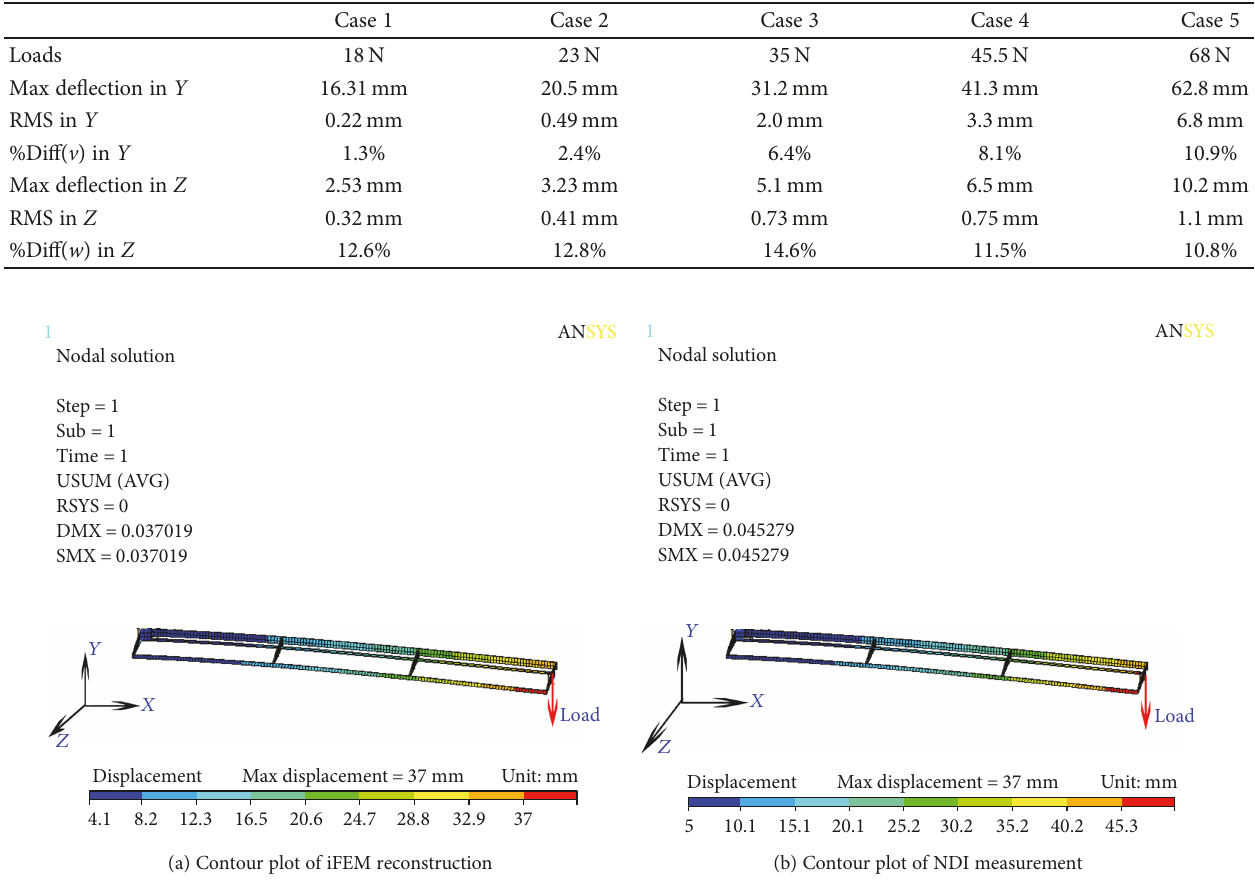
Table 3: Loading case for the frame structure. Max de fl ections are captured from NDI.